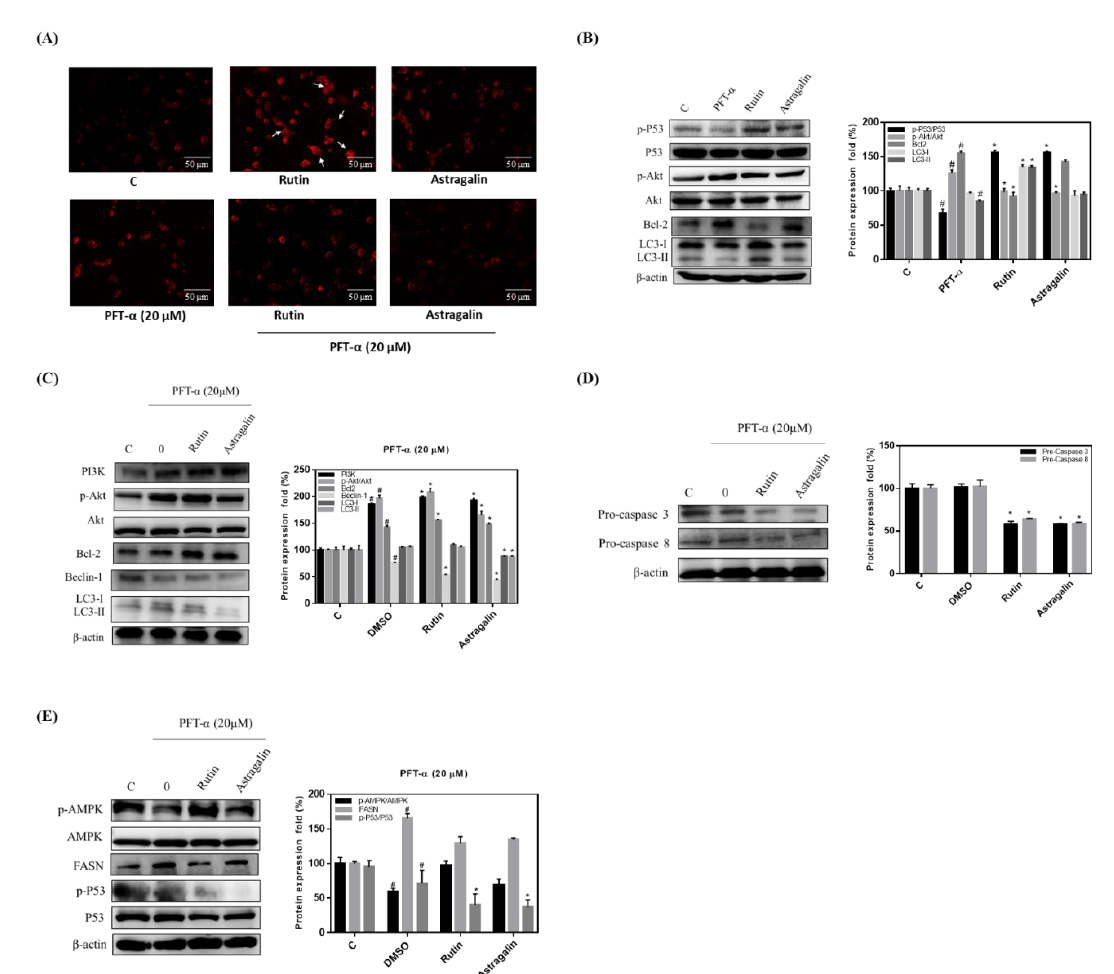
Figure 4. Rutin induced autophagy-dependent p53 in HepG2 cells. ( A ) HepG2 cells were treated with PFT α for 6 h and treated with 1 mM rutin, 0.1 mM of astragalin for 24 h and subjected to AVO staining. The arrow indicated AVO cells. AVOs values were calculated as the percentage of AVOs cells relative to the total number of cells in each random field. Results were statistically analyzed with Student’s t -test. Magnification: 400 × . ( B ) Cultured cells were treated with 1 mM rutin, 0.1 mM of astragalin, and PFT- α for 24 h, and whole-cell extracts were prepared as described in Materials and Methods. Equal amounts of total proteins were loaded in each lane of SDS-polyacrylamide gel (protein concentration is 50 µ g/ µ L). Western hybridization was performed with antibodies against p-P53/P53, pAkt/Akt, Bcl-2, LC3-I, and LC3-II. ( C ) PI3K, pAkt/Akt, Bcl-2, Beclin-1, LC3-I, and LC3II. ( D ) Pro-caspase 3, and pro-caspase 8. ( E ) pAMPK/AMPK, FASN, and p-P53/P53. Western blot analysis of β -actin was used as an internal control and represents the average of three independent experiments ± SD, n = 3. #, p < 0.05 compared with C. *, p < 0.05 compared PFT α